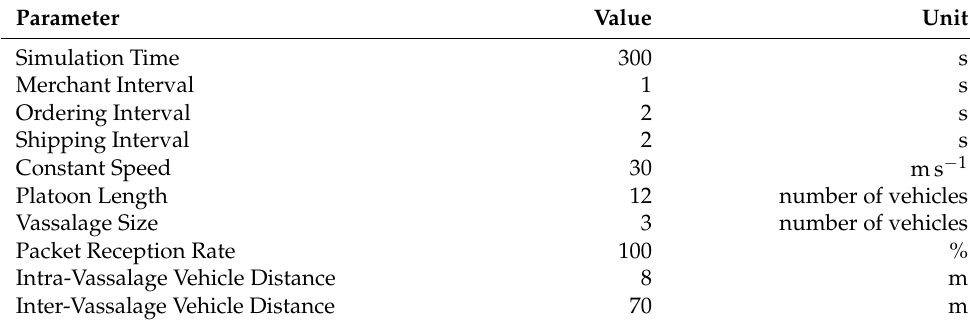
Table 1. Simulation parameters used for the presented